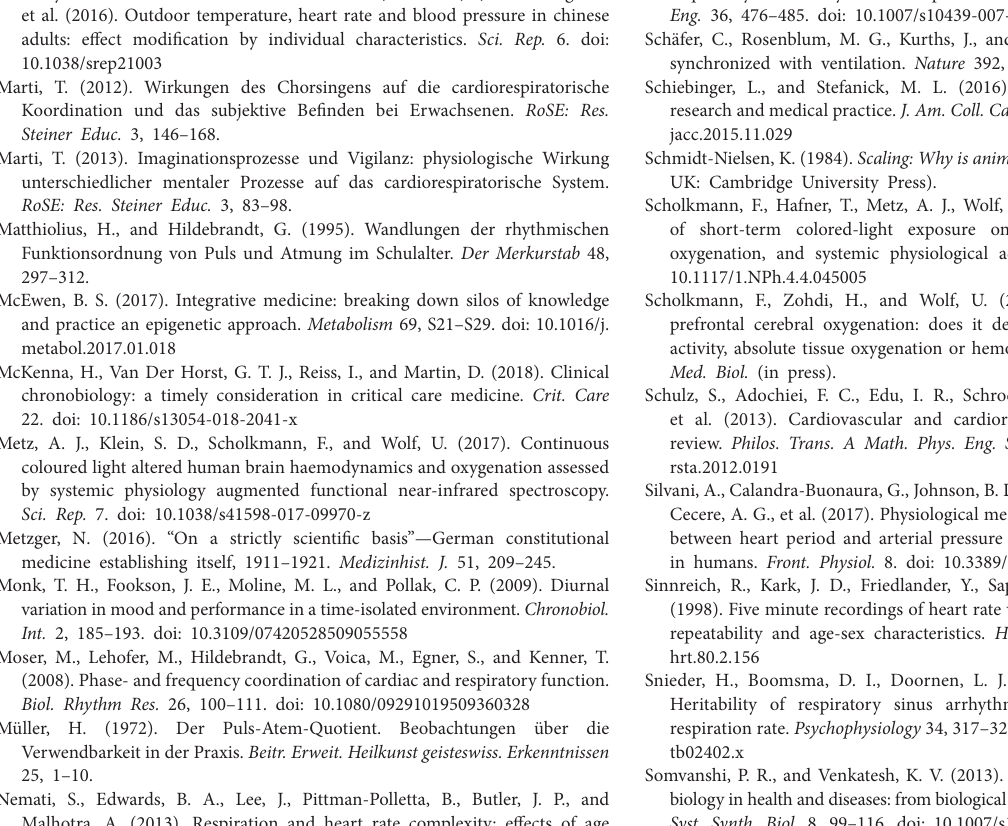
316:1865. doi: 10.1001/jama.2016.13995 Lenis, G., Kircher, M., Lázaro, J., Bailón, R., Gil, E., and Doessel, O.